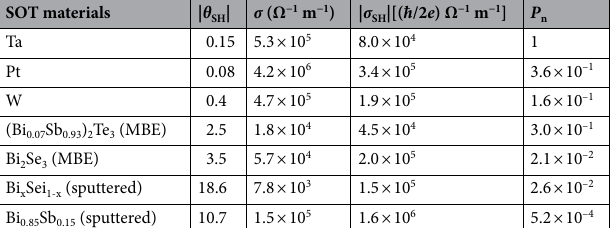
Table 1. Spin Hall angle θ SH , electrical conductivity σ , spin Hall conductivity σ SH , and SOT normalized power consumption P n of several heavy metals and topological